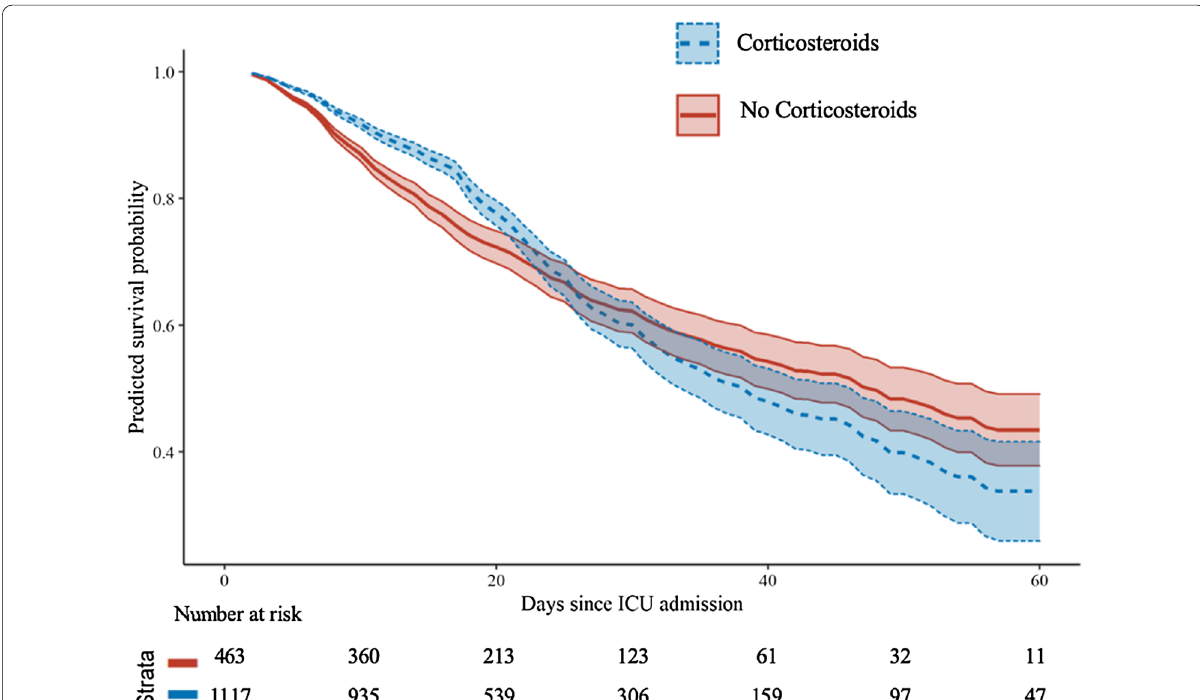
Fig. 3 Survival analysis with the cause‑specific hazard model and step function (time‑dependent Cox regression) to investigate the association of corticosteroids and ICU mortality over time. The estimated survival curves showed the estimated effect of exposure of corticosteroids on ICU mortality over time. Survival curves cross each other implying time‑dependency of corticosteroid exposure; hence step function approach was used to handle non‑proportional hazards assumption by stratification of time on day 17 of follow‑up when hazards changed the direction statistically significant. Then, the proportional hazards assumption was met for both periods. Models were adjusted for gender, age, body mass index, hospital GAP, ICU GAP, diagnosis GAP, shock, ACE inhibitors, ARBs, Comorbidity, asthma, COPD, chronic kidney disease, haematological disease, diabetes mellitus, neuromuscular disease, autoimmune disease, ischaemic heart disease, hypertension, immunosuppression, dyslipidaemia, hypothyroidism, APACHE II, SOFA, pulmonary infiltrates, lactate dehydrogenase, white blood cells count, creatinine, urea, C‑reactive protein, procalcitonin, Lactate, d ‑dimer, antibiotics, oseltamivir, lopinavir plus ritonavir, remdesivir, interferon, hydroxychloroquine, Tocilizumab, bacterial co‑infection, ARDS severity, fractional of inspired oxygen (FiO 2 ), positive end‑expiratory pressure, tidal volume, partial pressure of carbon dioxide, pH, RIFLE criteria, myocardial dysfunction and corticosteroid treatment (short and long‑term). ICU intensive care unit, ACE angiotensin‑converting enzyme, ARBs angiotensin receptor blockers, COPD chronic obstructive pulmonary disease, APACHE Acute physiology and chronic health